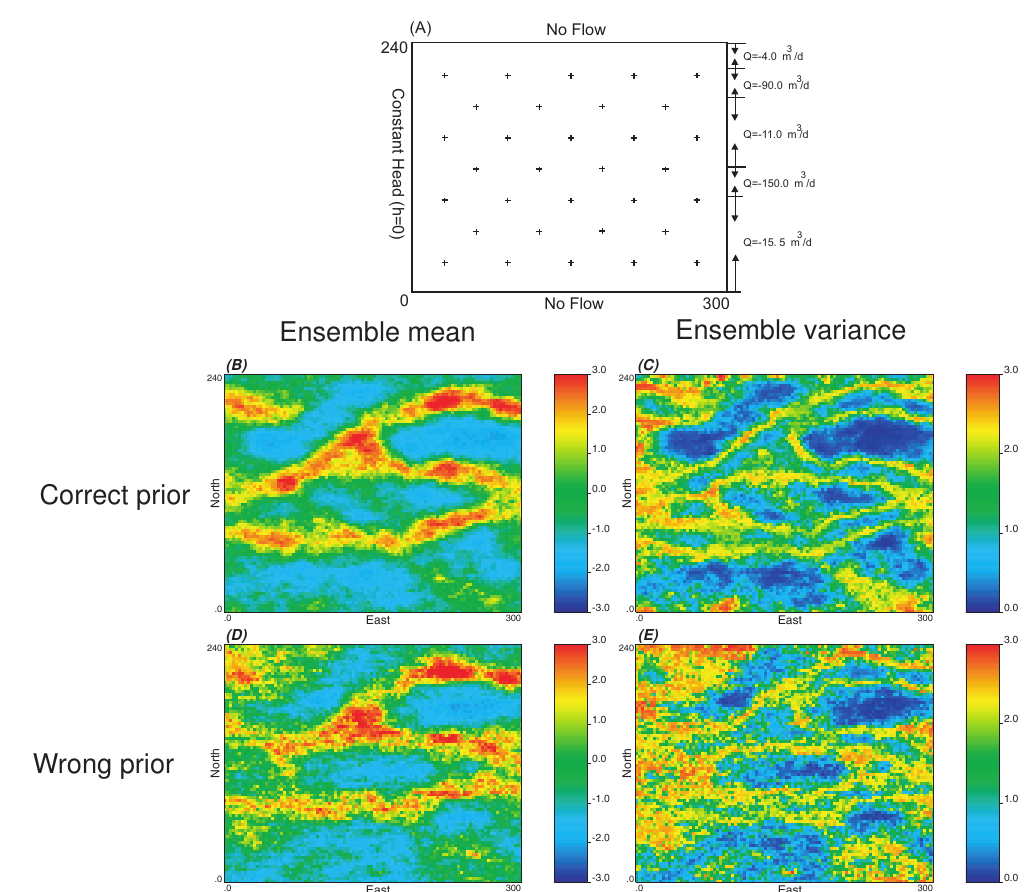
Fig. 10. (A) flow configuration and spatial distribution of sampled head data. (B) the ensemble mean of logconductivity with correct prior model. (C) the ensemble variance of logconductivity with correct prior model. (D) the ensemble mean of logconductivity with wrong prior model. (E) the ensemble variance of logconductivity with wrong prior model.